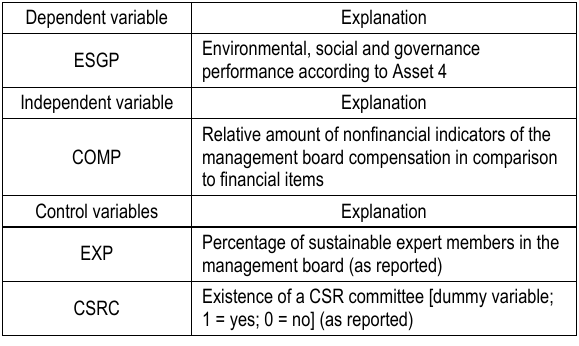
Table 2. Variables of the study